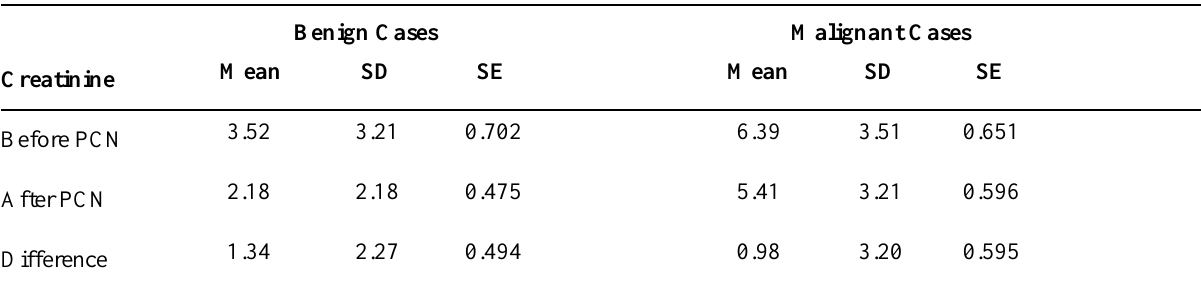
Table 5 – Comparison in serum creatinine (mg/dL) in benign (n = 21) and malignant (n = 29) cases before and after percutaneous nephrostomy